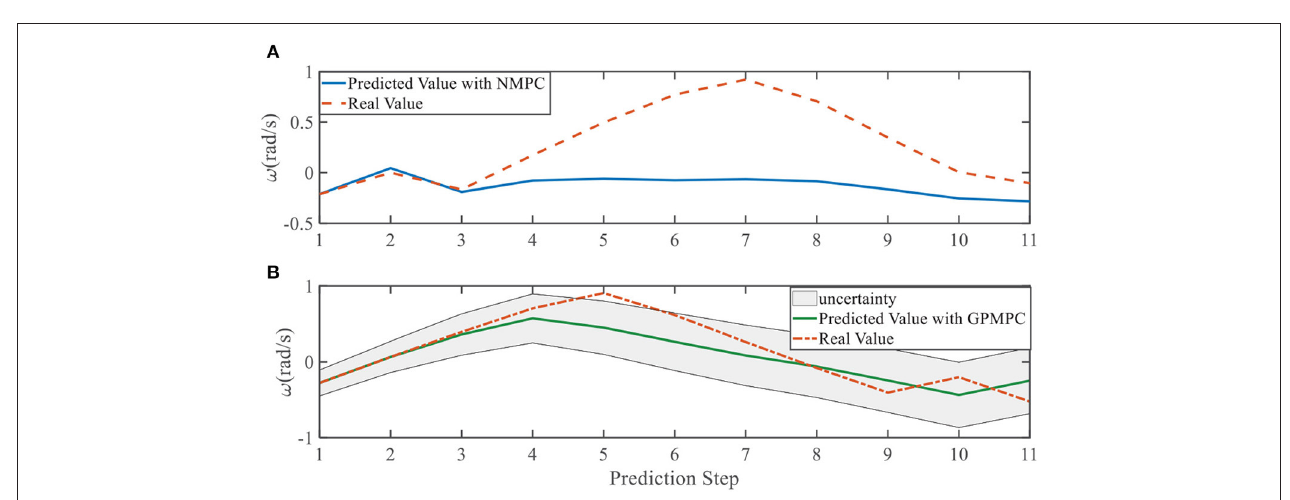
FIGURE 12 | Yaw rate evolution in left overtaking. (A) NMPC; (B) GPMPC.